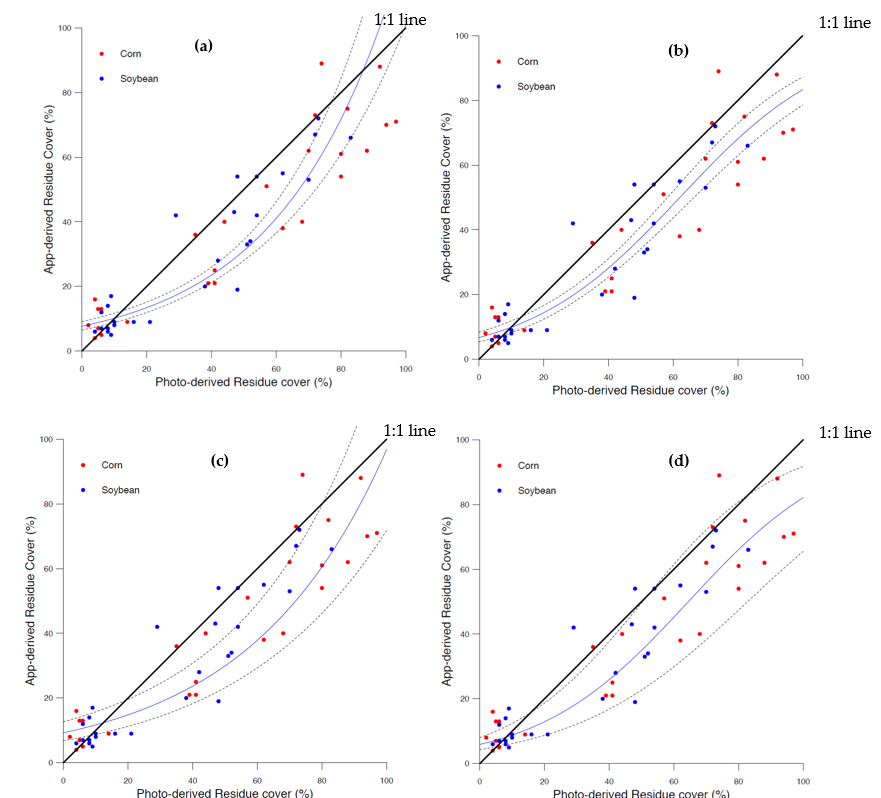
Figure 5. Relationships between residue cover percent as determined by photograph-grid and app with 95% CI: ( a ) OLS log-linear regression; ( b ) OLS logit-linear regression, ( c ) generalized Poisson regression; ( d ) Beta regression with logit link.